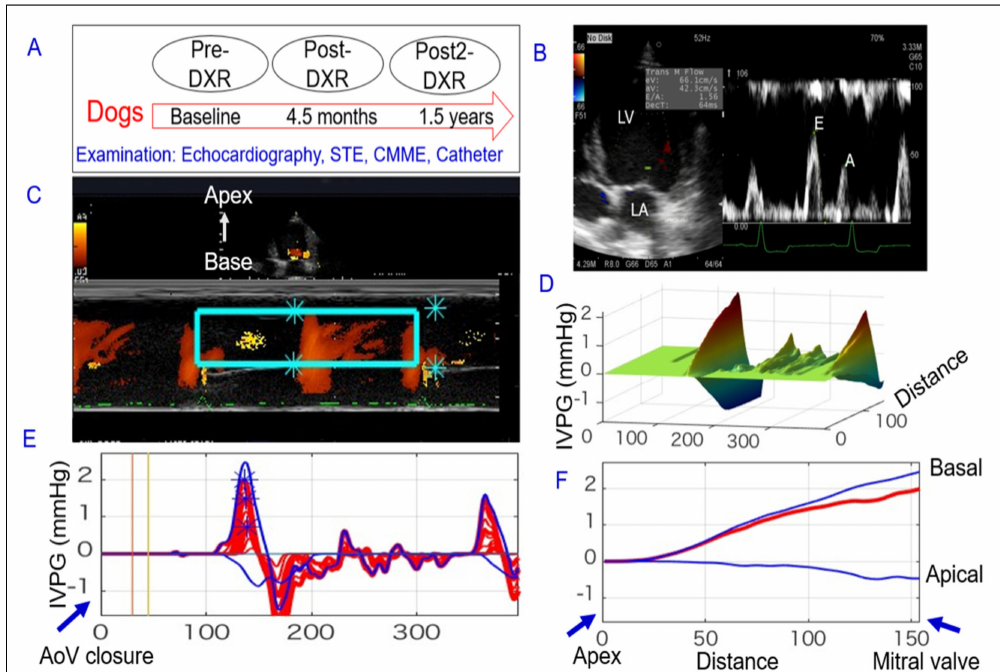
Figure 1. Schematic representation of the used procedures to evaluate cardiac function during doxorubicin-induced cardiomyopathy in dogs. Catheterization and different echocardiographic approaches (conventional, two-dimensional speckle tracking (2DSTE), color M-mode echocardiography (CMME)) were carried out at three time-points; Pre, Post, and Post2-doxorubicin (DXR) administration ( A ). After optimizing the mitral inflow from the left apical view ( B ), CMME was switched on to trace the inflow tract from the left atrium (LA) to the apex of the left ventricle (LV). CMME images ( C ) were used for IVPG assessment after determination of the area of interest (mitral inflow, rectangular green box) using MATLAB software, by which the 3D temporal and spatial profile of IVPG ( D ), and IVPG time distribution ( E , F ) were calculated using Euler’s